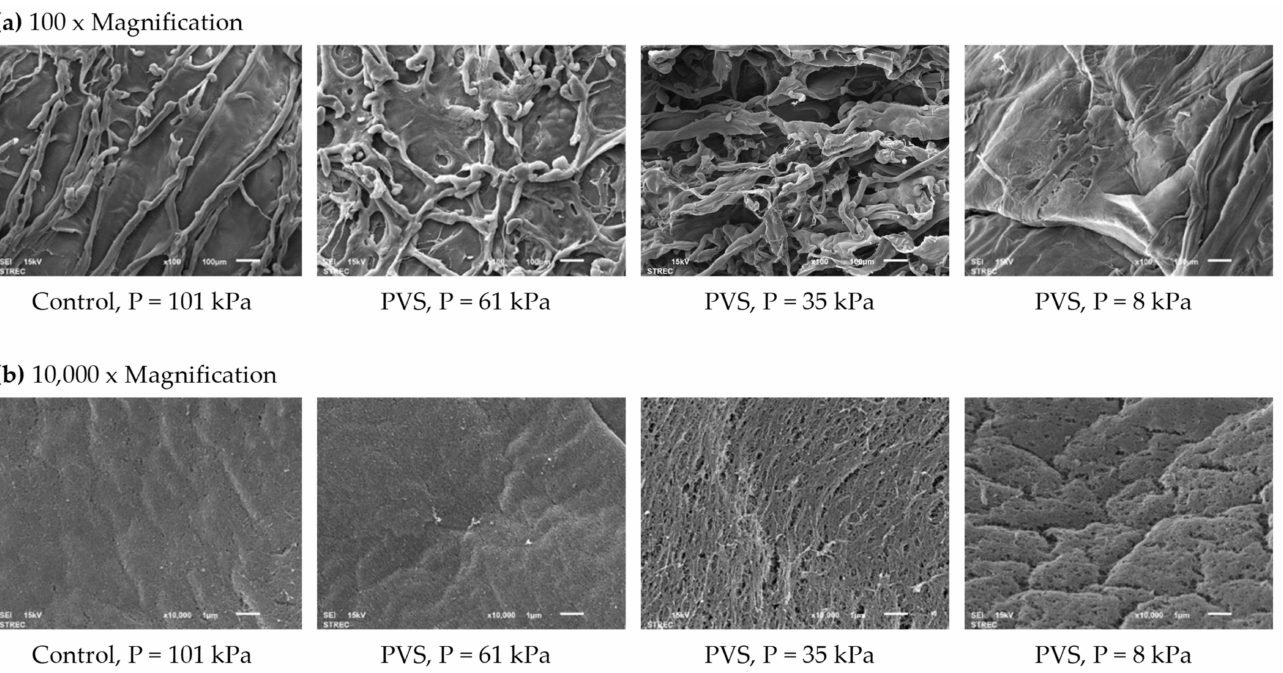
Figure 4. SEM images of the external structures of the calcium-alginate hydrogel balls as affected by different working pressures for 3 cycles at ( a ) 100 × Magnification and ( b ) 10,000 × Magnification (1 cycle of control = 60 min of soaking during the external gelation process, while 1 cycle of PVS = 10 min of depressurization and 10 min of vacuum liberation for 3 repetitions (60 min)).